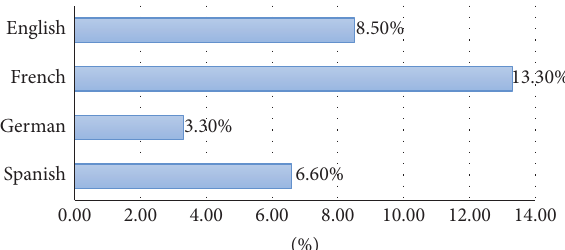
Figure 1: Rates of HON-accredited websites within each tertile group.